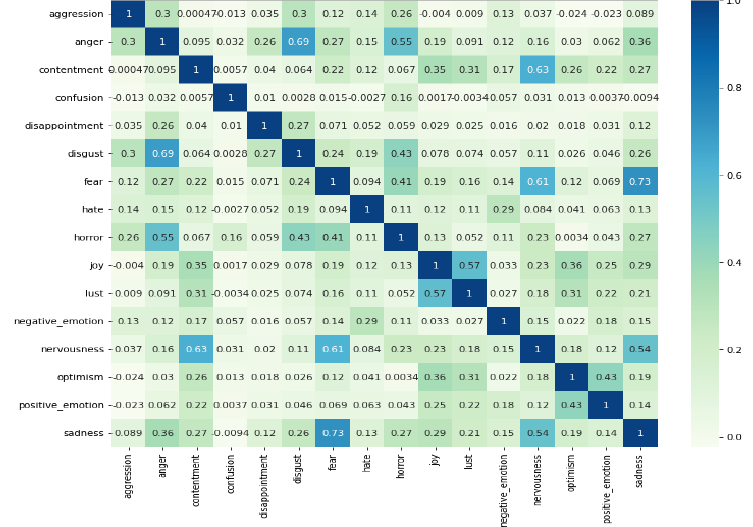
Figure 5 . Correlation heat map for scores of empath